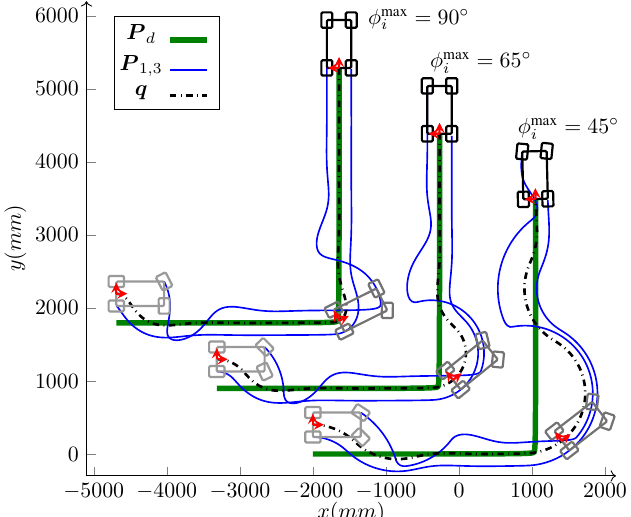
Figure 18. Experiment : Path-following of iMoro in car-like mode with three steering limits: = φ max 45 ◦ ,65 ◦ ,90 ◦ i { }